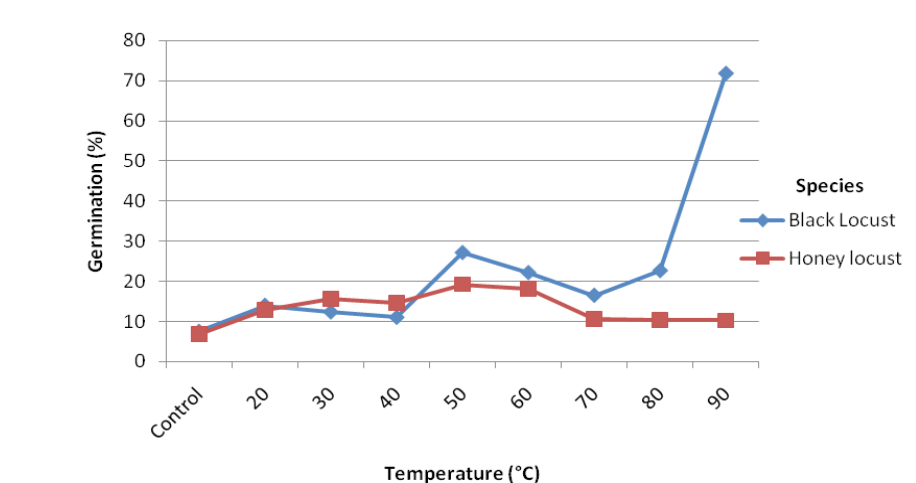
Fig. 3. The effect of different temperatures and durations on germination rates of black locust ( Robinia pseudoacacia L.) and honey locust ( Gleditsia triacanthos L.)